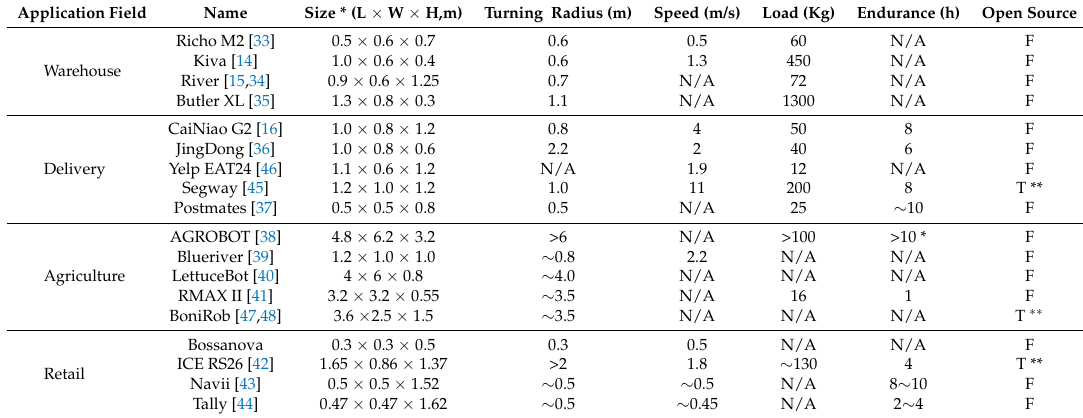
Table 1. Overview of Intelligent Transportation Systems (ITS) and typical agricultural